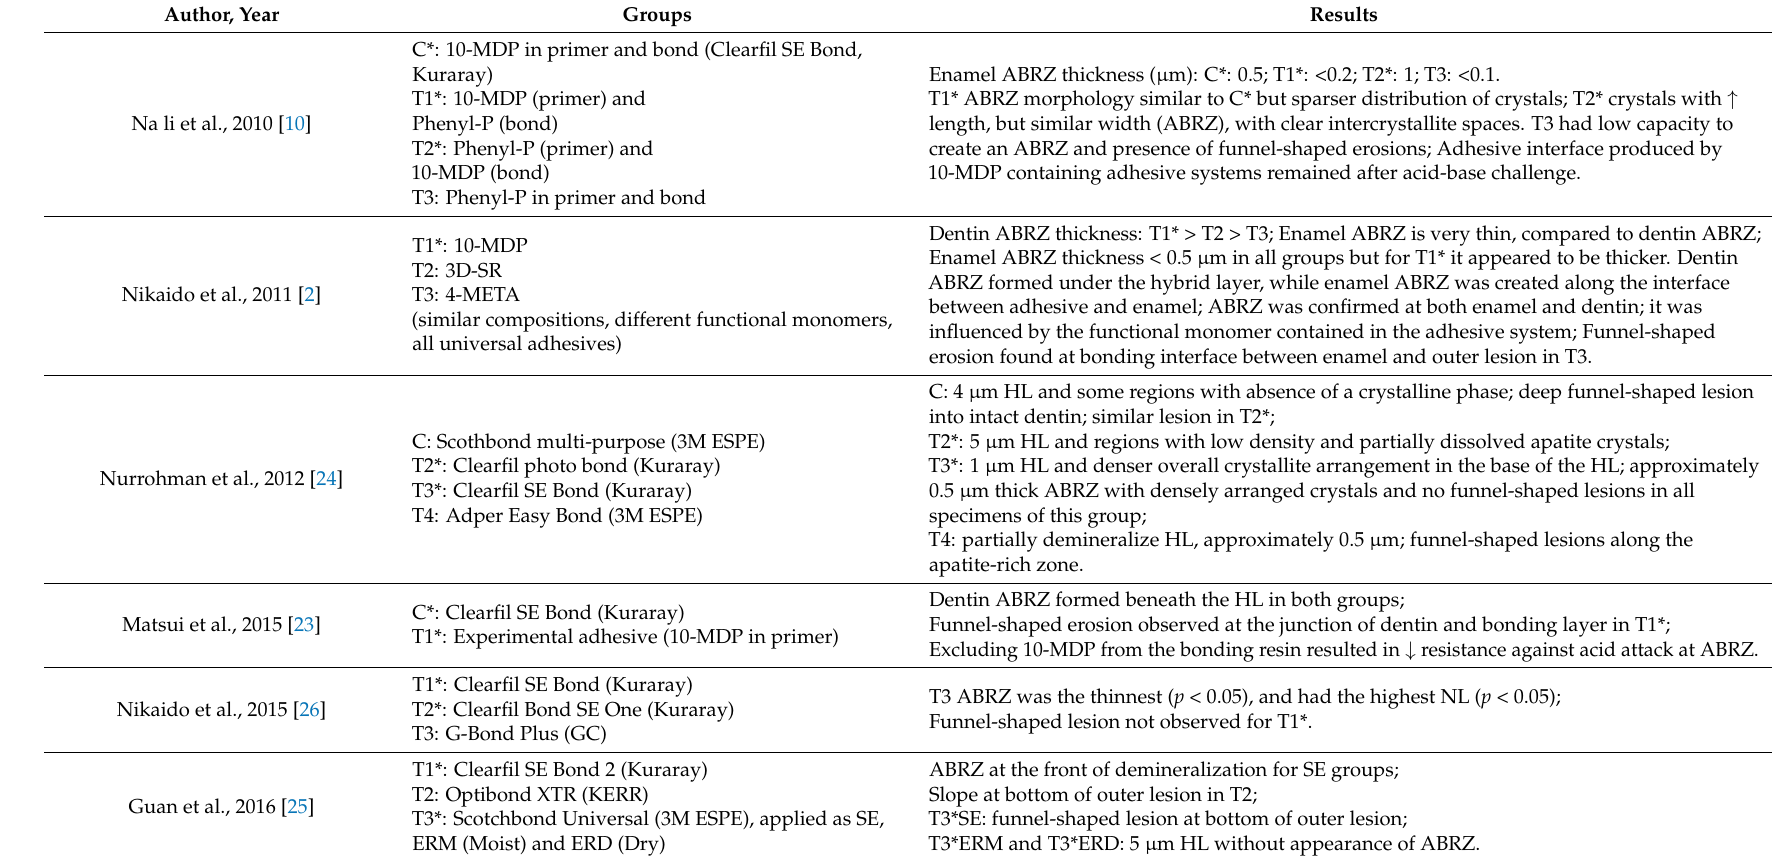
Table 5. Acid-Base Resistant Zone